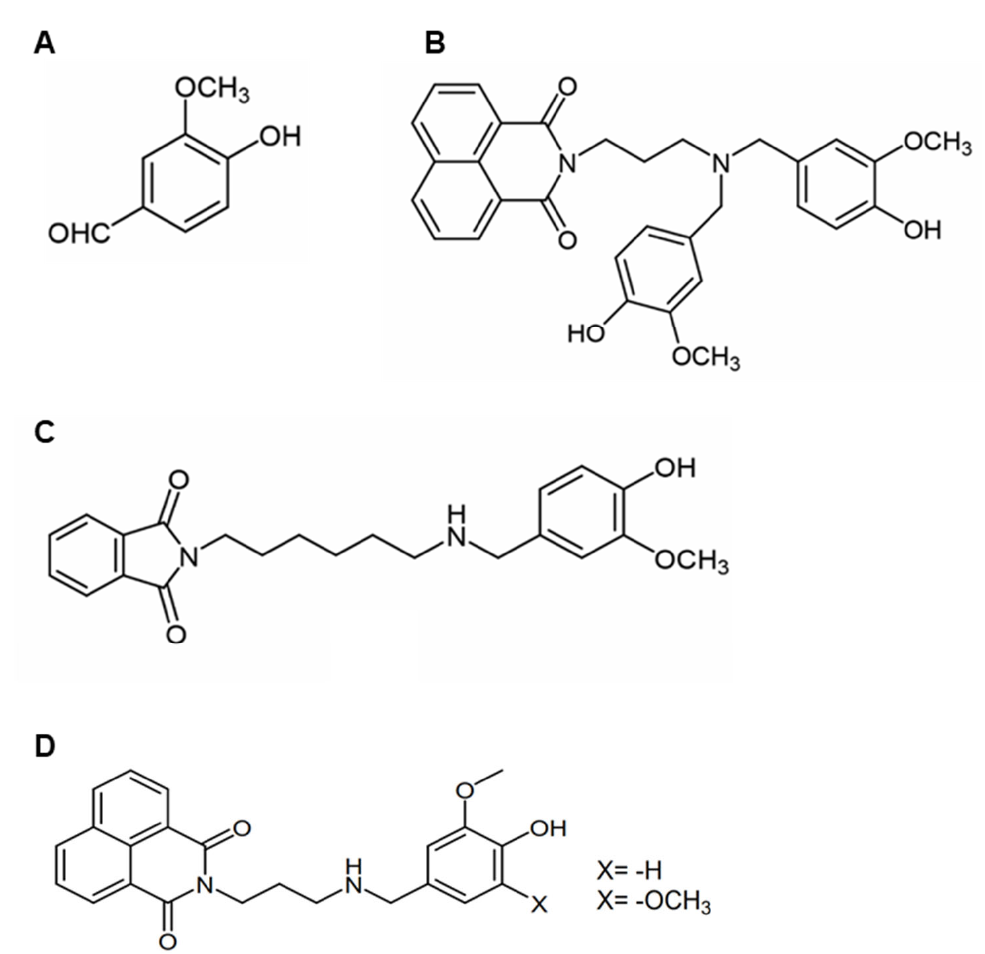
Figure 1. Chemical structure of vanillin and its derivatives: ( A ) Vanillin; ( B ) di-vanillin derivative with naphthalimide; ( C ) mono-vanillin derivative with phthalimide; ( D ) vanillin–naphthalimide compounds.